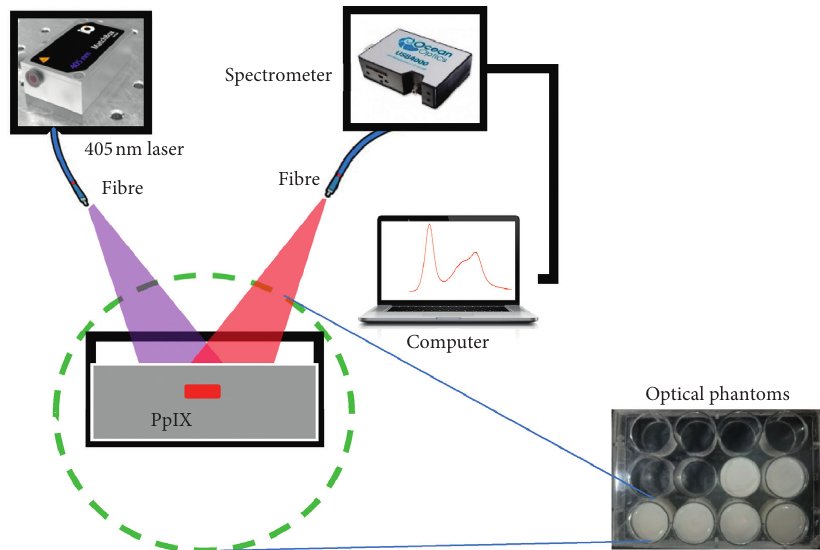
Figure 1: Overview of the optical setup used for recording fluorescence spectra emanated from buried fluorescence inclusions in the brain tissue-like optical